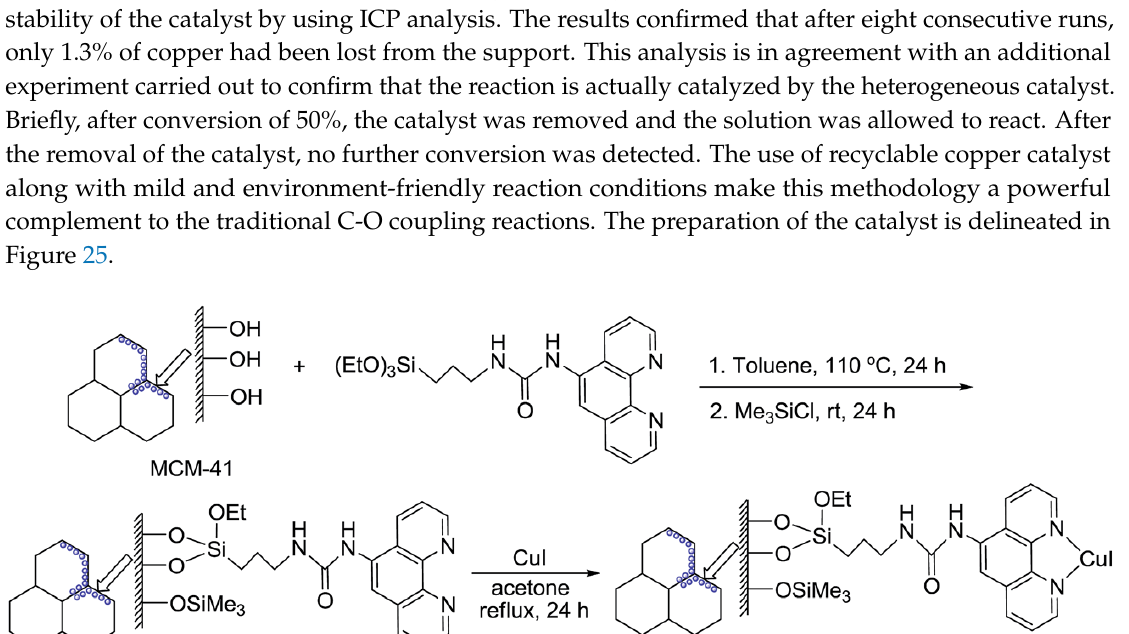
Figure 24. Synthesis process of Cu(II)-Et-S@mcm-41 in the three separate steps. Reproduced with